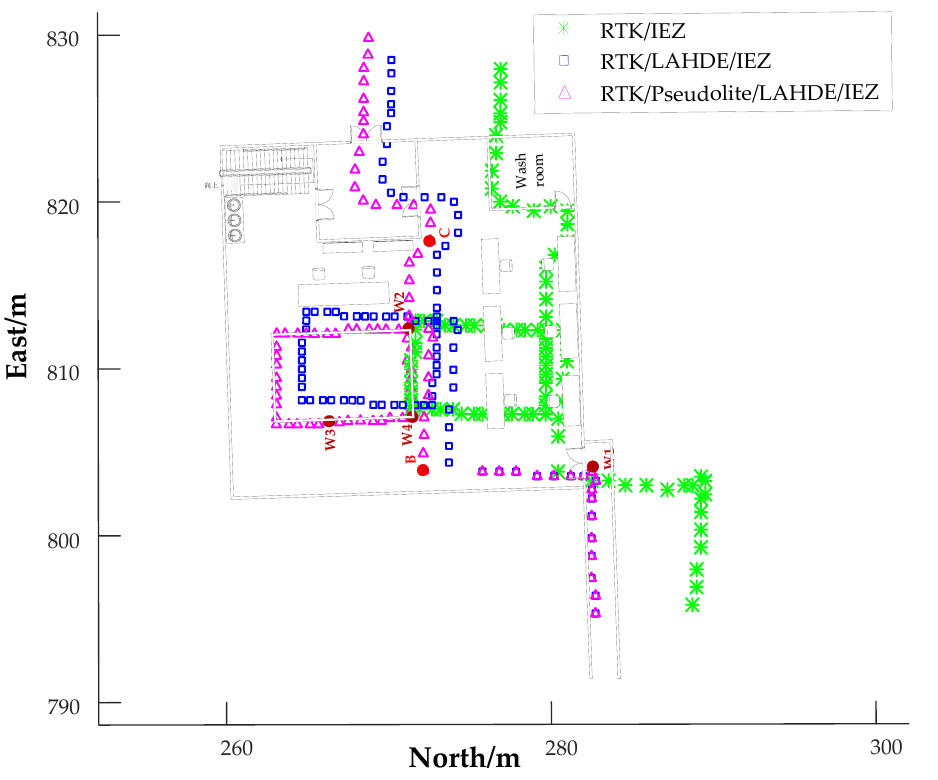
Figure 14. The trajectories of indoor corridor and indoor room parts ignoring positioning error at point A of Person A.